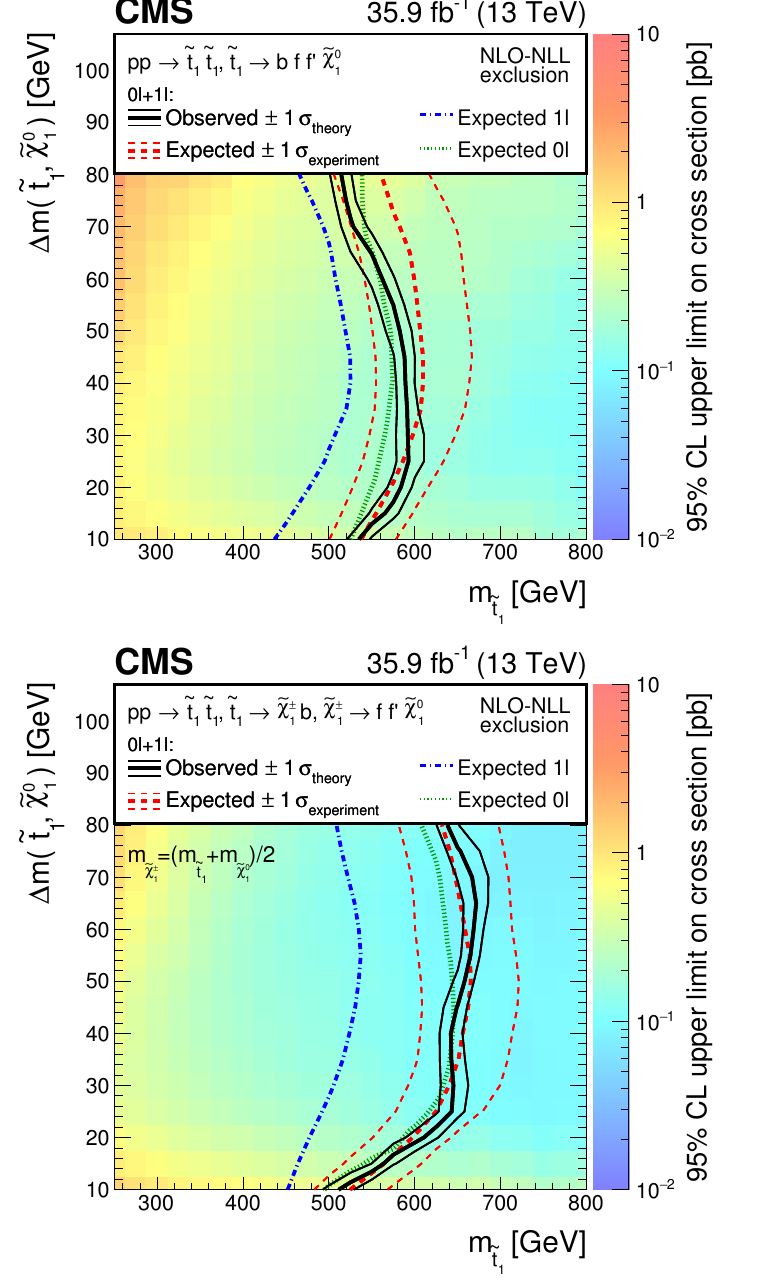
Figure 9 . Combined limits at 95% CL between the CC single-lepton (1 ‘ ) and all-hadronic (0 ‘ ) [19] searches for the four-body decay (upper) and the chargino-mediated decay (lower) of the top squark in the m ( (cid:31) 0 ) plane. The correlations between the two searches have been taken into 1 account. The colour shading corresponds to the observed limit on the cross section. The solid black (dashed red) lines show the observed (expected) mass limits, derived using the expected top squark pair production cross section. The thick lines represent the central values and the thin lines the variations due to the theoretical (experimental) uncertainties. The dot-dashed blue and dotted green lines show the individual expected mass limits for the 1 ‘ and 0 ‘ searches,